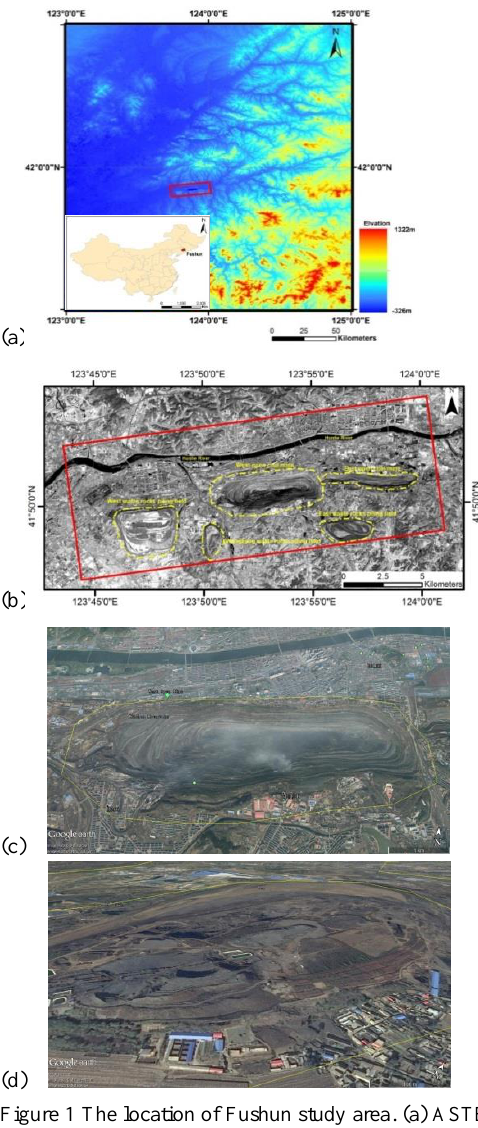
Figure 1 The location of Fushun study area. (a) ASTER GDEM of Fushun study area. The index map shows the location of Fushun city and the red rectangle is the study area. (b) ZY-3 image of Fushun study area (2015-10-24). The yellow dot dash lines show the main open mining areas and waste rocks piling fields in this area. (c) West Open Mine and (d) Wangliang Waste Rocks Piling Field from Google